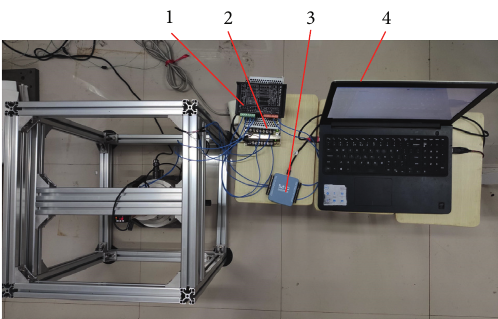
Figure 12: Test system. 1, drive; 2, power supply; 3, data acquisition board; 4, upper